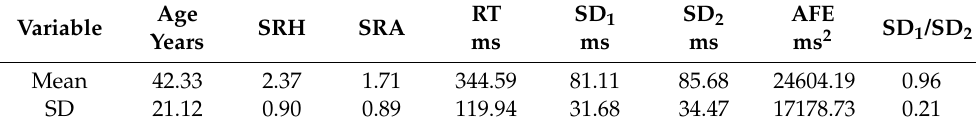
Table 1. Statistic indicators for investigated parameters in the experimental group ( n =